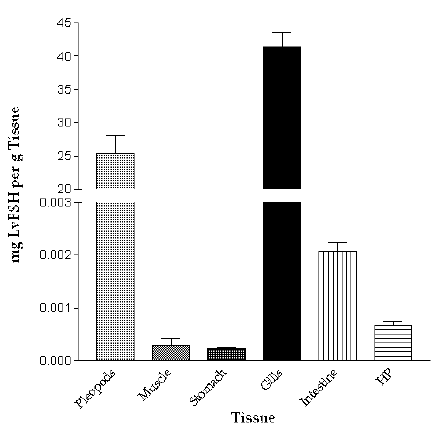
. Figure 8. LvFSH immunodetection in Litopenaeus vannamei tissues by Figure 8 . LvFSH immunodetection in Litopenaeus vannamei tissues by ELISA